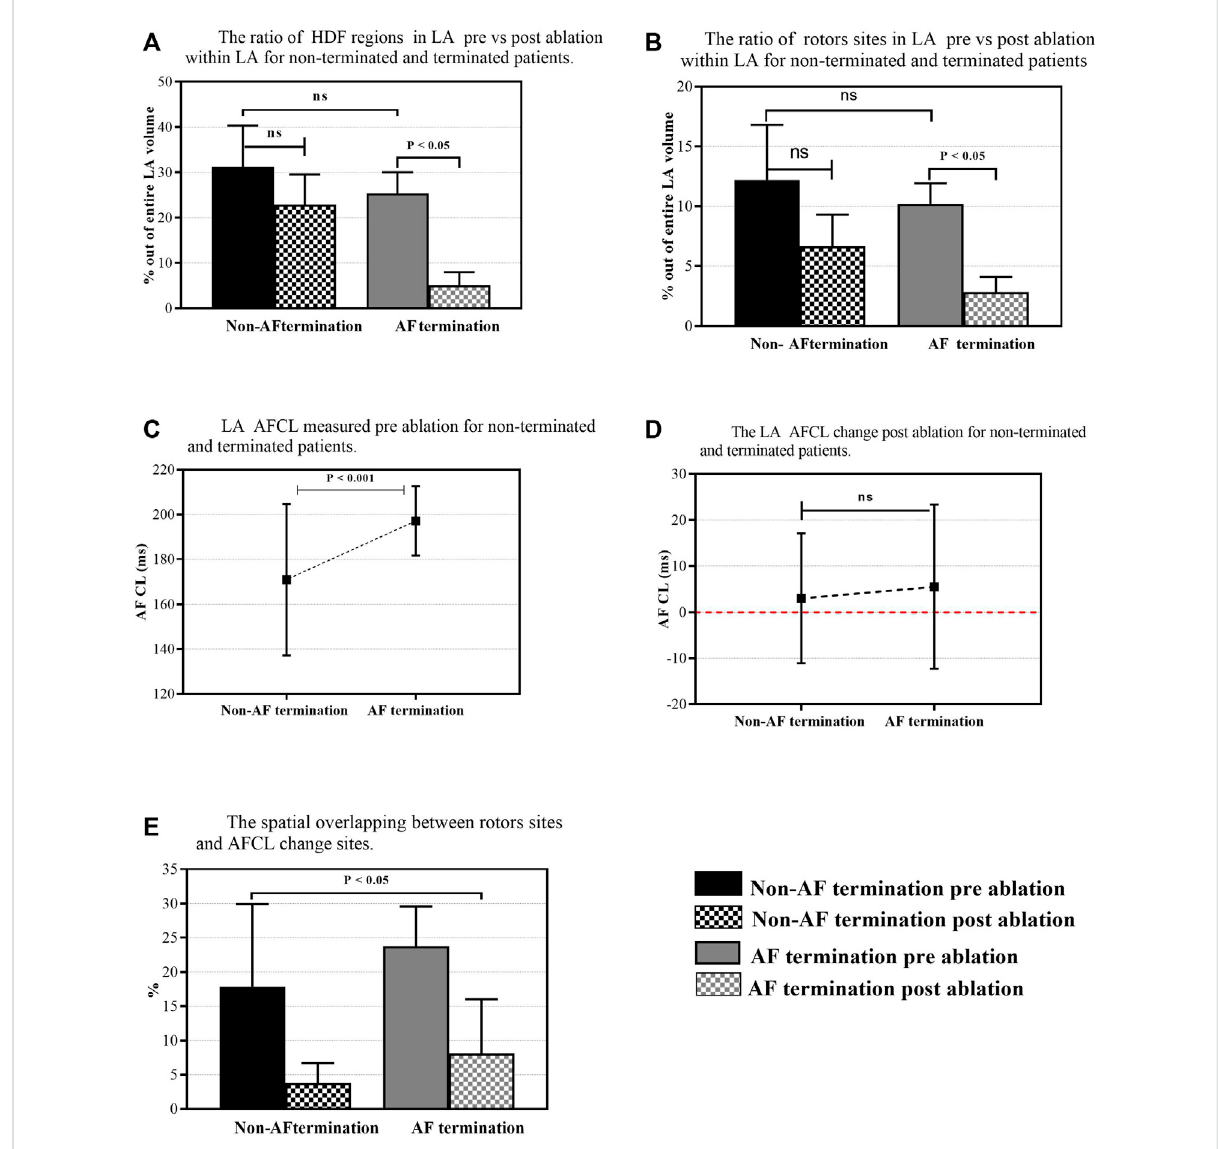
FIGURE 6 Theoverallpercentageofrotors ’ sitesandHDFregionsoutoftheentireLAarea. (A) Theratiooftherotors ’ sitesthroughtheLApre-versuspost- ablation for non-terminated and terminated patients. (B) The ratio of the HDF regions through the LA pre-versus post-ablation for non-terminated and terminated patients. (C) LA AFCL measured pre-ablation for non-terminated and terminated patients. (D) LA AFCL change was measured post- ablation for non-terminated and terminated patients. (E) The spatial overlapping between rotors ’ sites and AFCL change